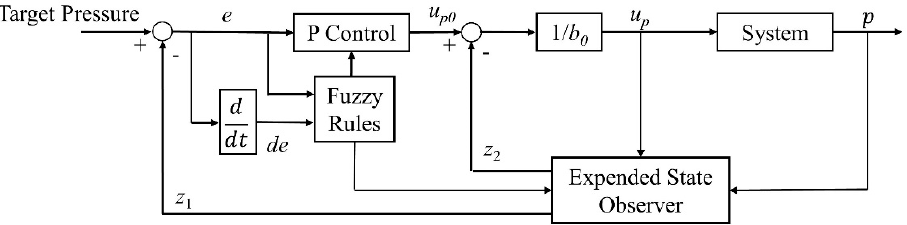
Figure 11. Boom cylinder pressure control structure using FLADRC.